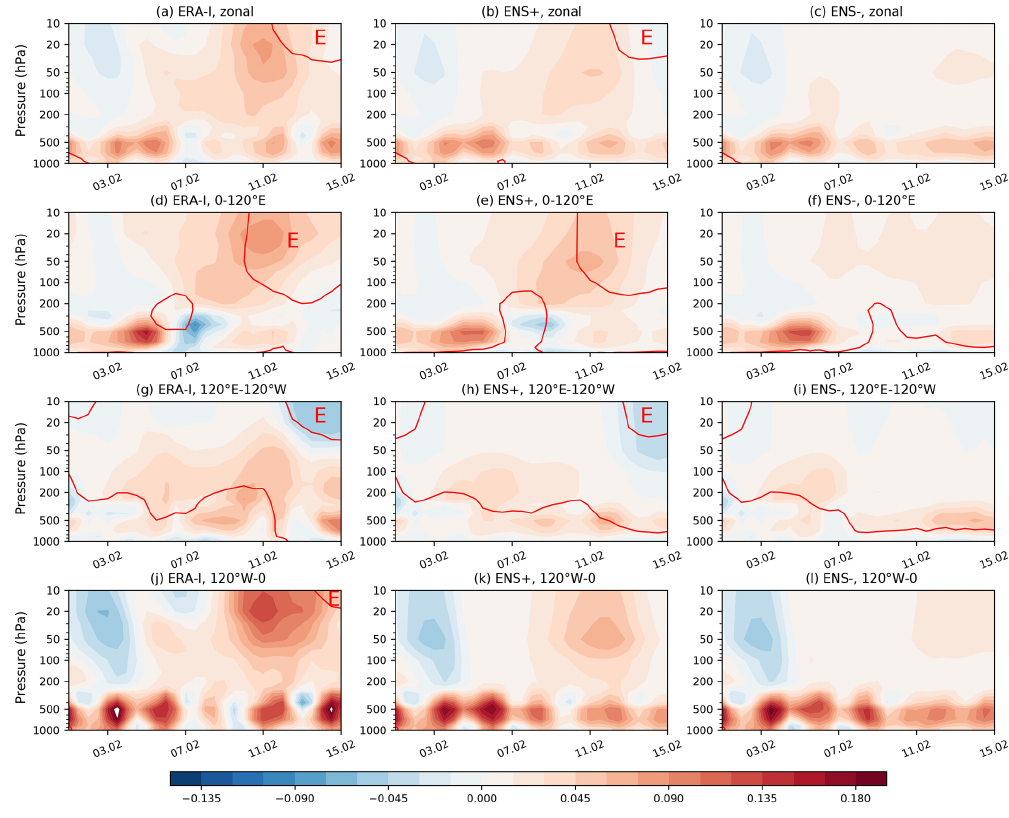
Figure 7. Time–altitude plot of the vertical component of WAF (m 2 s − 2 , shaded, averaged over 45–90 ◦ N, vertically scaled by √ (1000hPa) /p ) and zero zonal wind contour (red) averaged over 55–65 ◦ N. (a–c) Zonally averaged; (d–f) averaged over 0–120 ◦ E; (g– i) averaged over 120 ◦ E–120 ◦ W; (j, i) averaged over 120–0 ◦ W. The red letter “E” denotes regions of easterly winds. (a, d, g, i) ERA-I; (b, e, h, k) ENS + composite; (c, f, i, l) ENS − composite.